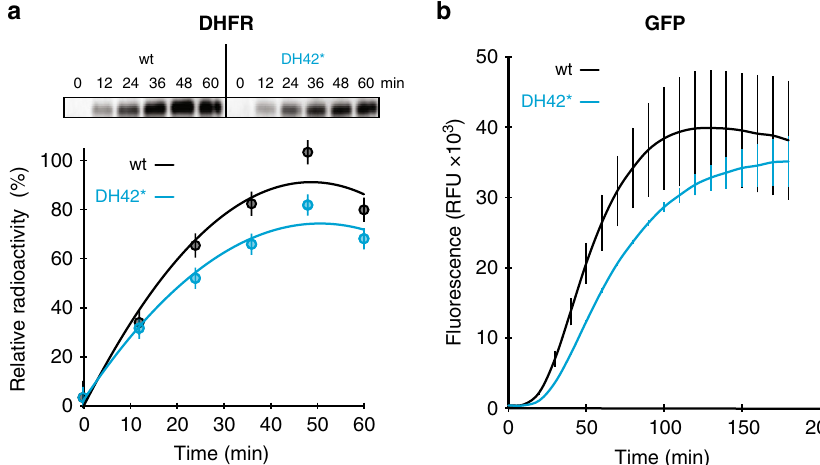
Fig. 4 Functional ribosomes with the hybrid 23S-cp5S rRNA are highly active in translation. a In vitro translation of dihydrofolate reductase (DHFR) protein by wt ribosomes or23S-cp5S rRNA DH42* ribosomes. Top: SDS – gel analysis of [ 35 S]-labeled DHFR protein synthesized in the cell-free translation system. The intensities of the full-size protein bands were plotted in the graph shown below the gel (mutant — blue curve, wt — black curve). b Time course of in vitro expression of sfGFP protein by wt or mutant ribosomes as evaluated by fl uorescence (mutant — blue curve, wt — black curve). Graphs shown in a and b represent the average of three independent experiments with error bars indicating s.d. The uncropped gels and raw data can be found in the Source data fi